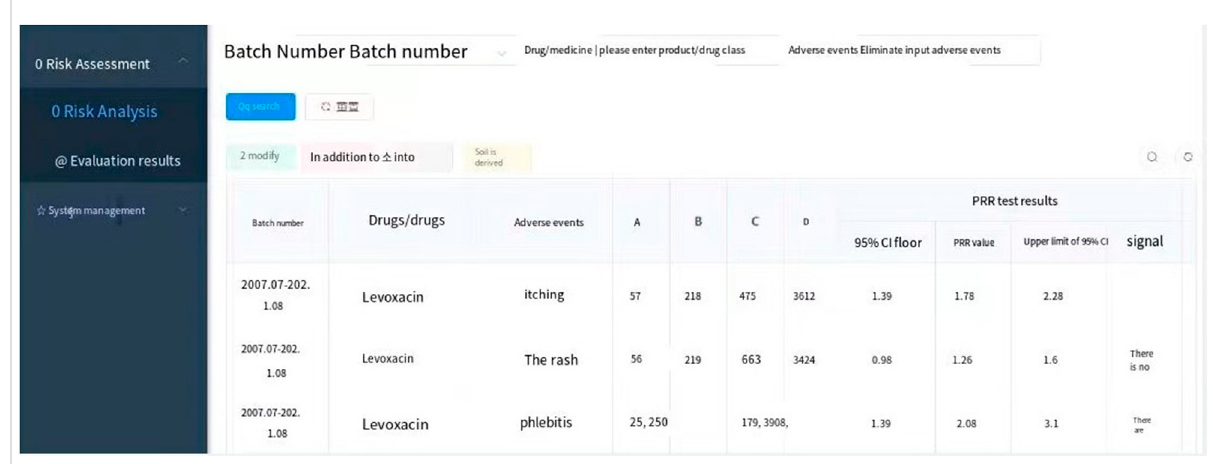
FIGURE 1 Output interface of the results and risk prompt of the four signal detection